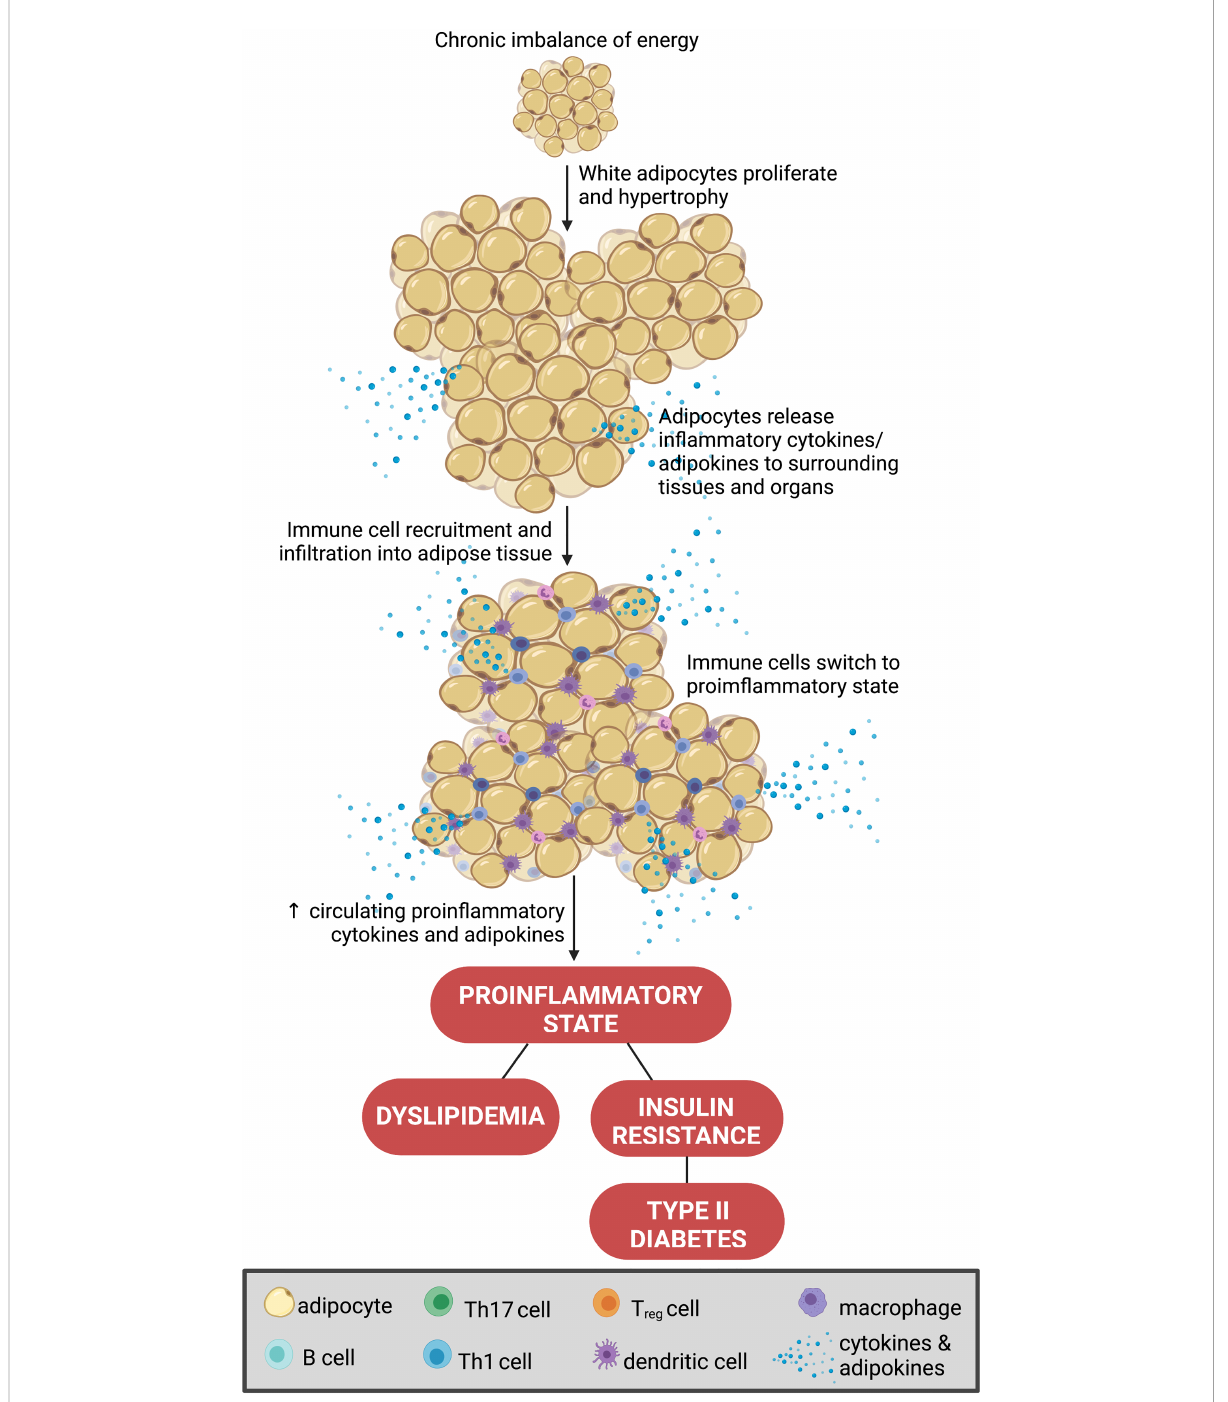
FIGURE 1 Adipocyte biology in obesity. A chronic imbalance of increased energy intake and or reduced energy expenditure increases adiposity, via hypertrophy and proliferation of white adipocytes. This promotes the secretion of pro-in fl ammatory cytokines (i.e., tumor necrosis factor alpha (TNF- a ), interleukin 6 (IL-6), IL-1 b , and IL-10) to aid the in fi ltration of pro-in fl ammatory immune cells into the adipose tissue and surrounding organs (16). This process promotes dyslipidemia, insulin resistance and hyperglycemia further exacerbating the dysregulation of whole-body energy homeostasis. Created with